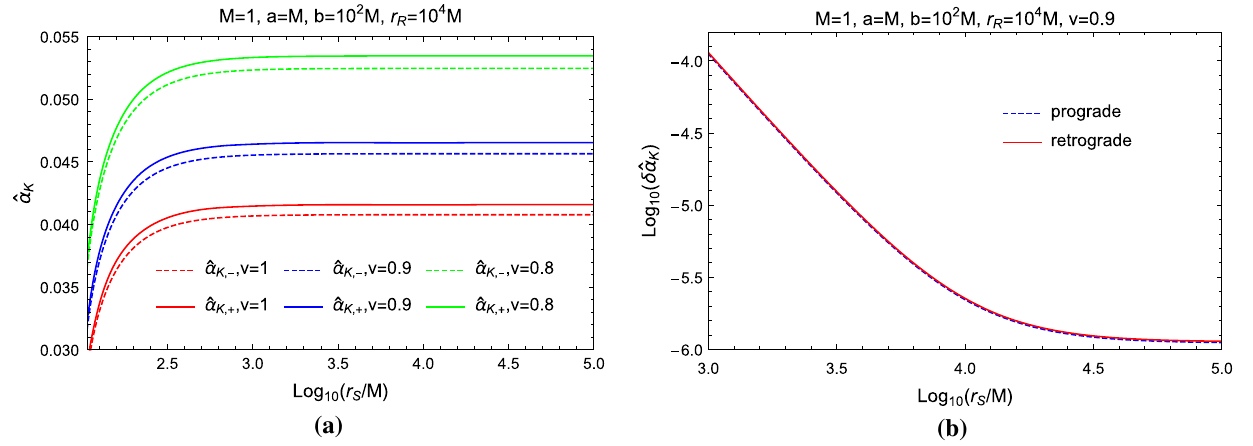
Fig. 2 The finite-distance deflection angles of massless and massive particles in Kerr BH spacetime. a The deflection angle itself, Eq. (42) as a function of r S for three velocities and the retrograde motion ( ˆ α K , + )